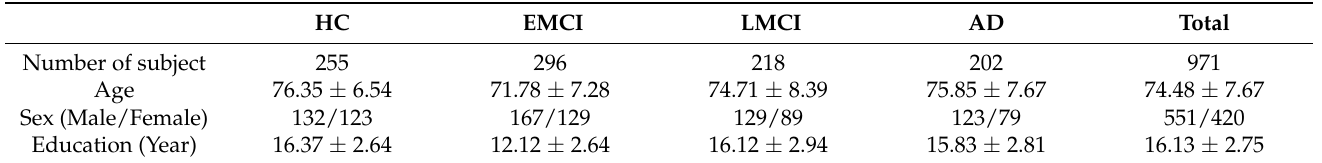
Table A1. Participant characteristics.